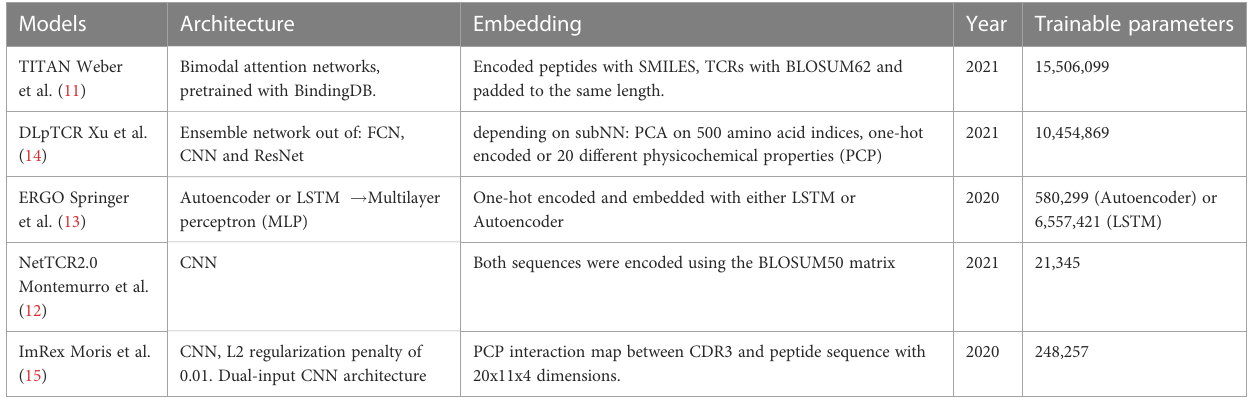
TABLE 1 Overview of the tested models.